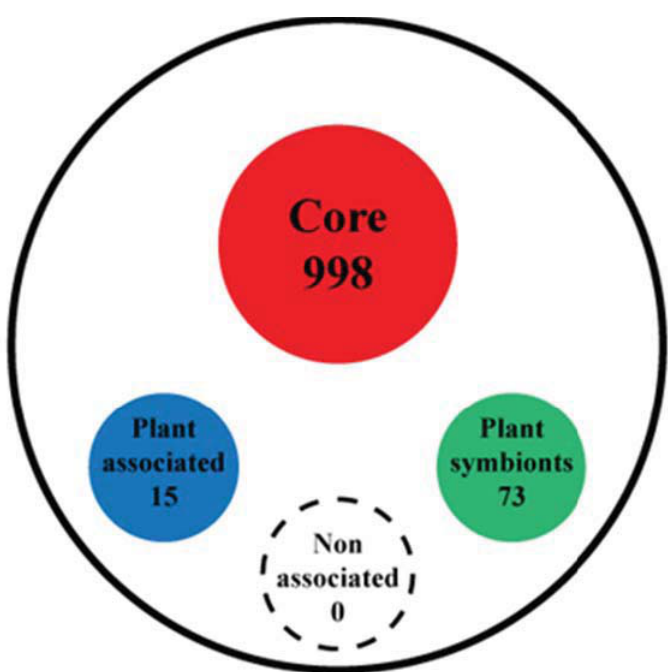
Figure 2. Number of orthologous groups found inside each life-style species list. Circles sizes are not in